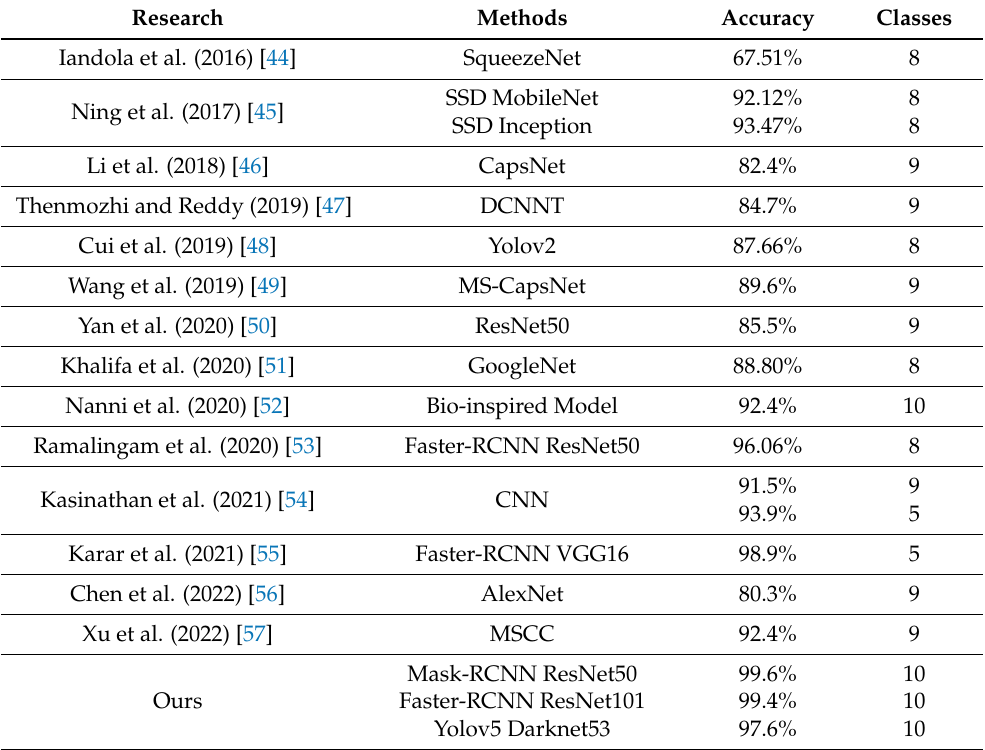
Table 3. Method comparison on IP102